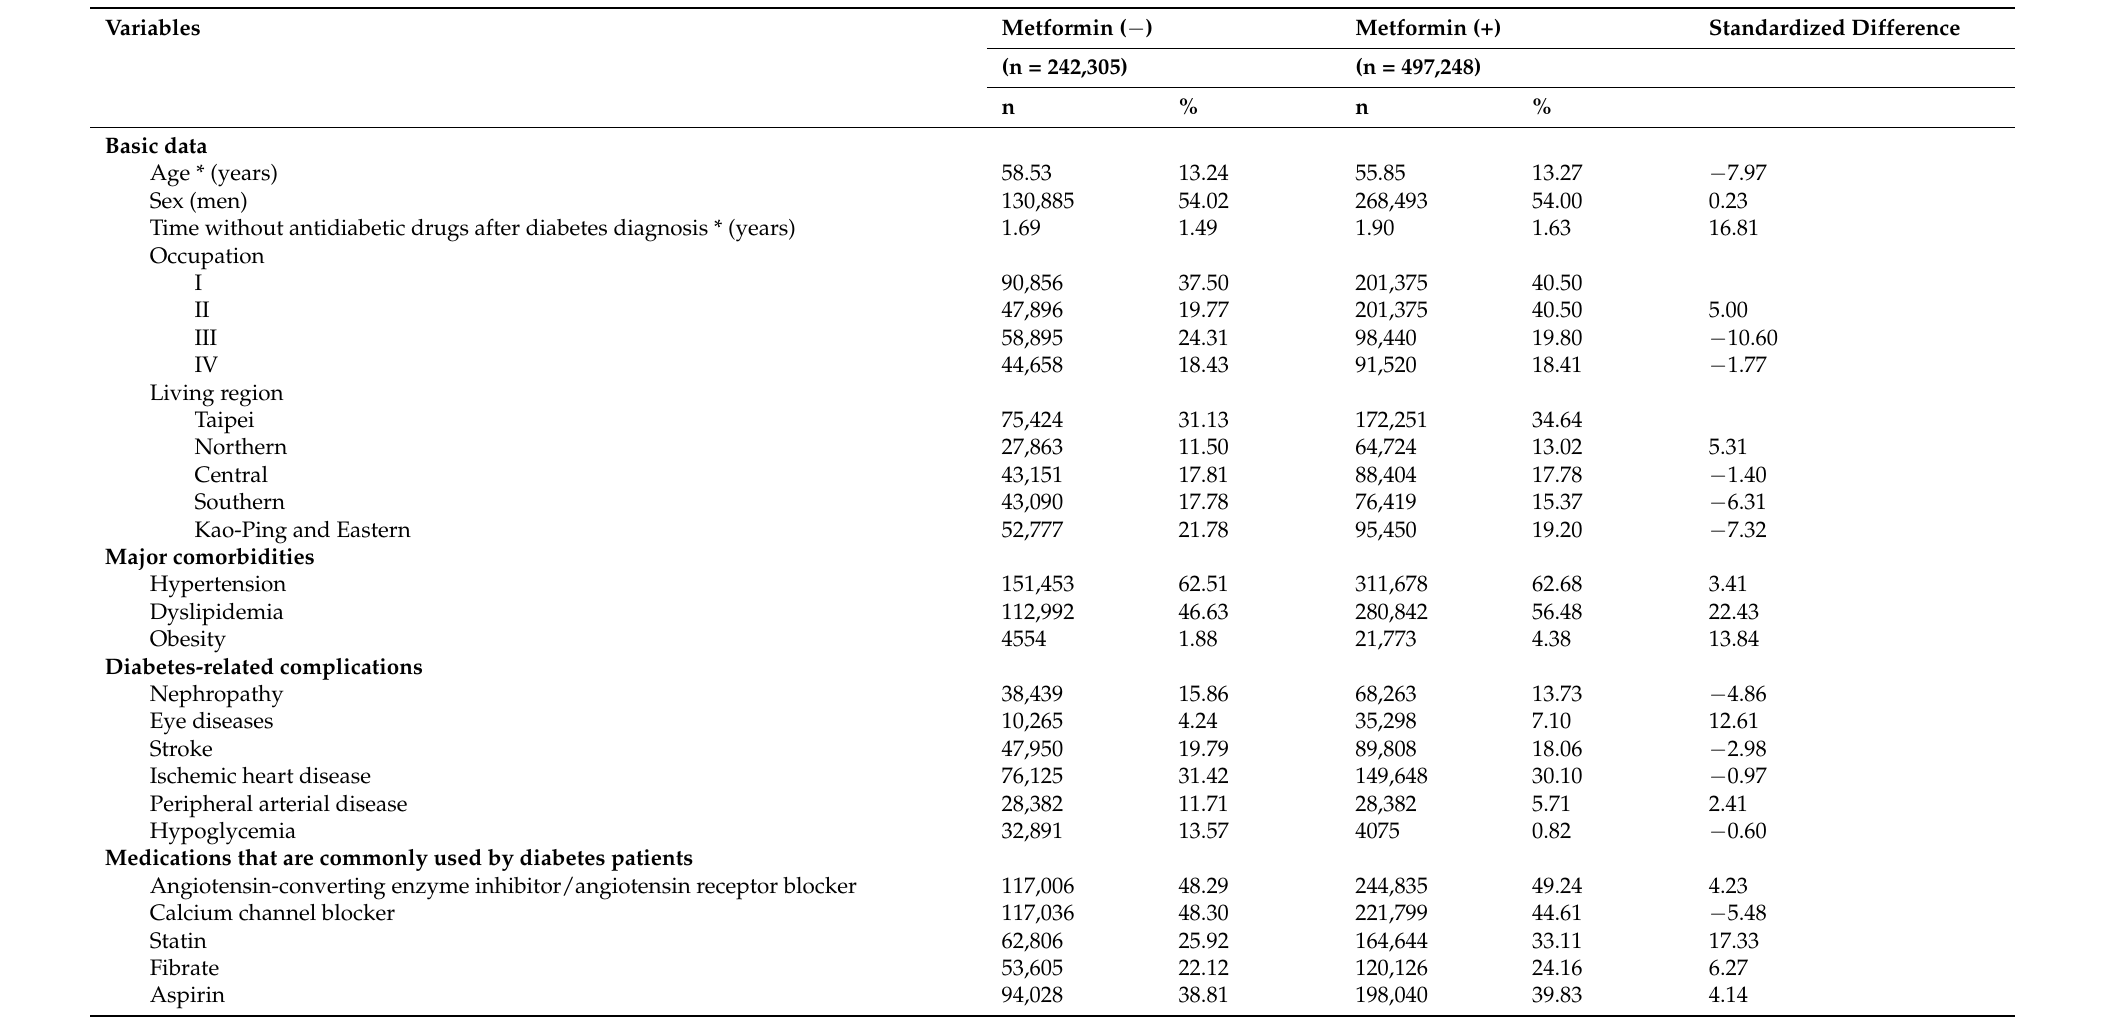
Table 1. Characteristics of metformin initiators (metformin (+)) and non-metformin initiators (metformin ( −